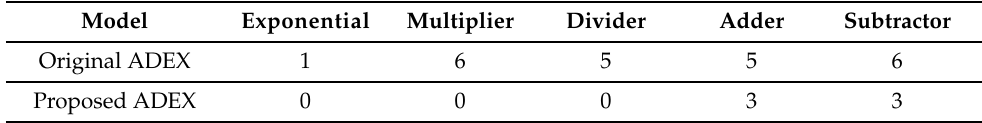
Table 5. Minimum required resources of the original and proposed ADEX models.